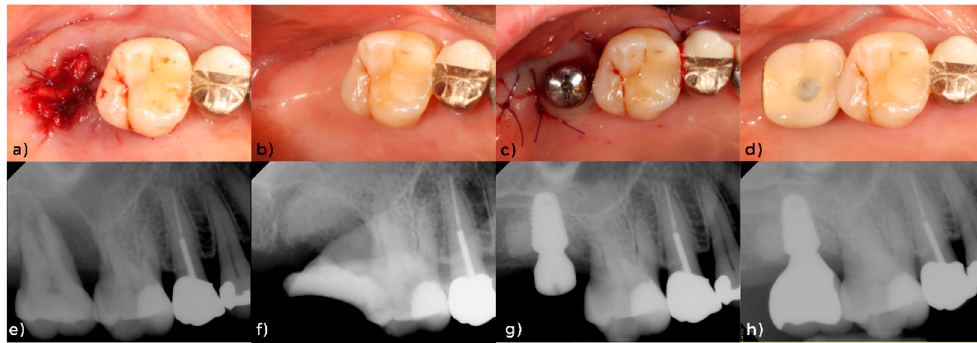
Figure 2. Clinical photos and peri-apical radiographs of Case II. Clinical photos of ( a ) after alveolar ridge preservation (ARP), ( b ) two years after ARP, ( c ) after implantation, ( d ) after prosthesis delivery. Peri-apical radiographs of ( e ) before extraction, ( f ) after ARP, ( g ) after implantation, ( h ) after prosthesis delivery.